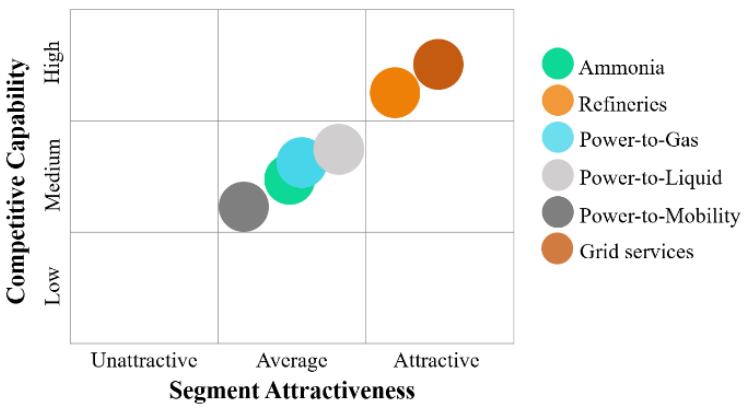
Figure 3. Short-term prospects of market segments for solid oxide electrolysis businesses